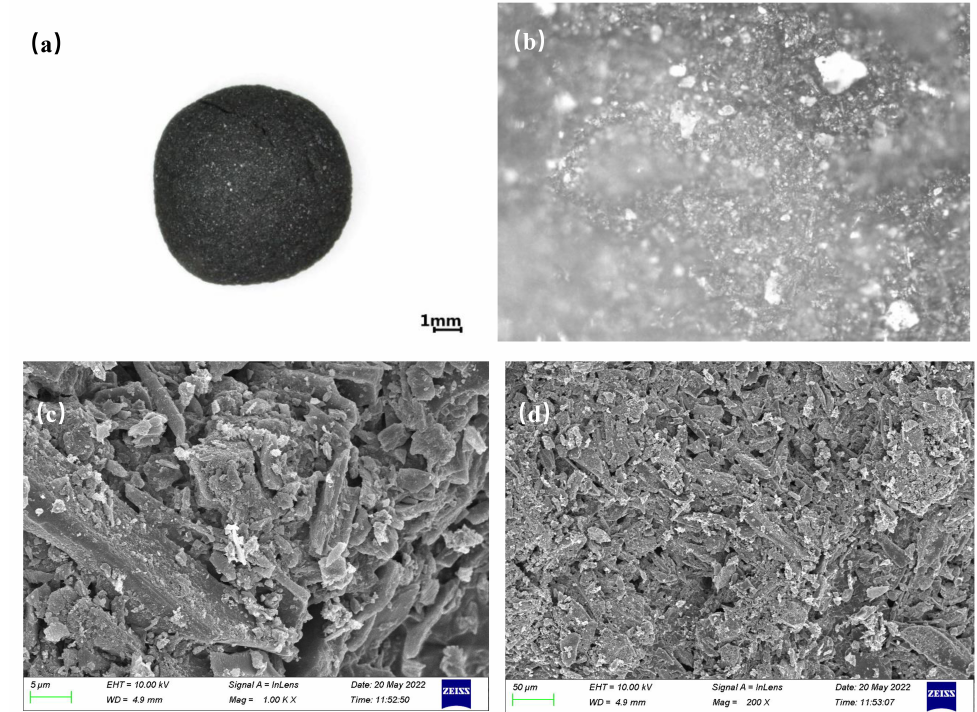
Figure 1. ( a ) Stereoscope of La-CZ; ( b ) Polarizing microscope of La-CZ; ( c , d ) SEM micrographs of La-CZ with the magnification of images